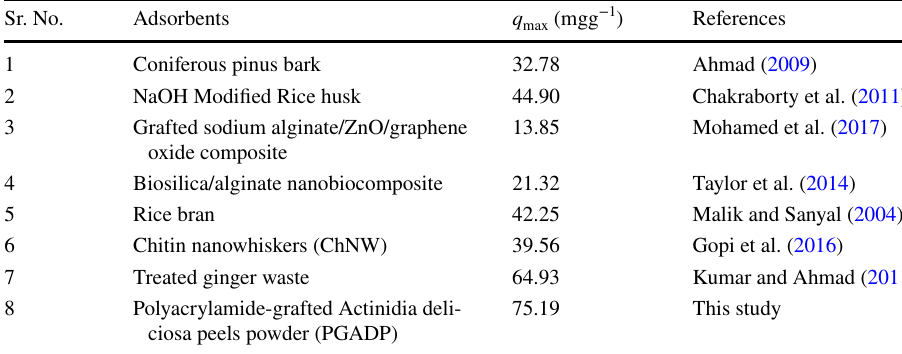
Table 5 Comparison of crystal violet adsorption capacity with various